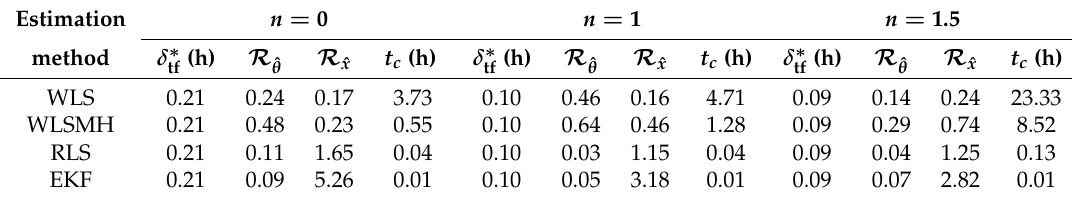
Table 1. Comparison of the rate of the suboptimality of final processing times, the normalized root mean squared error for unknown parameters and concentrations and the computational time for different estimation techniques. MH, moving horizon; RLS, recursive